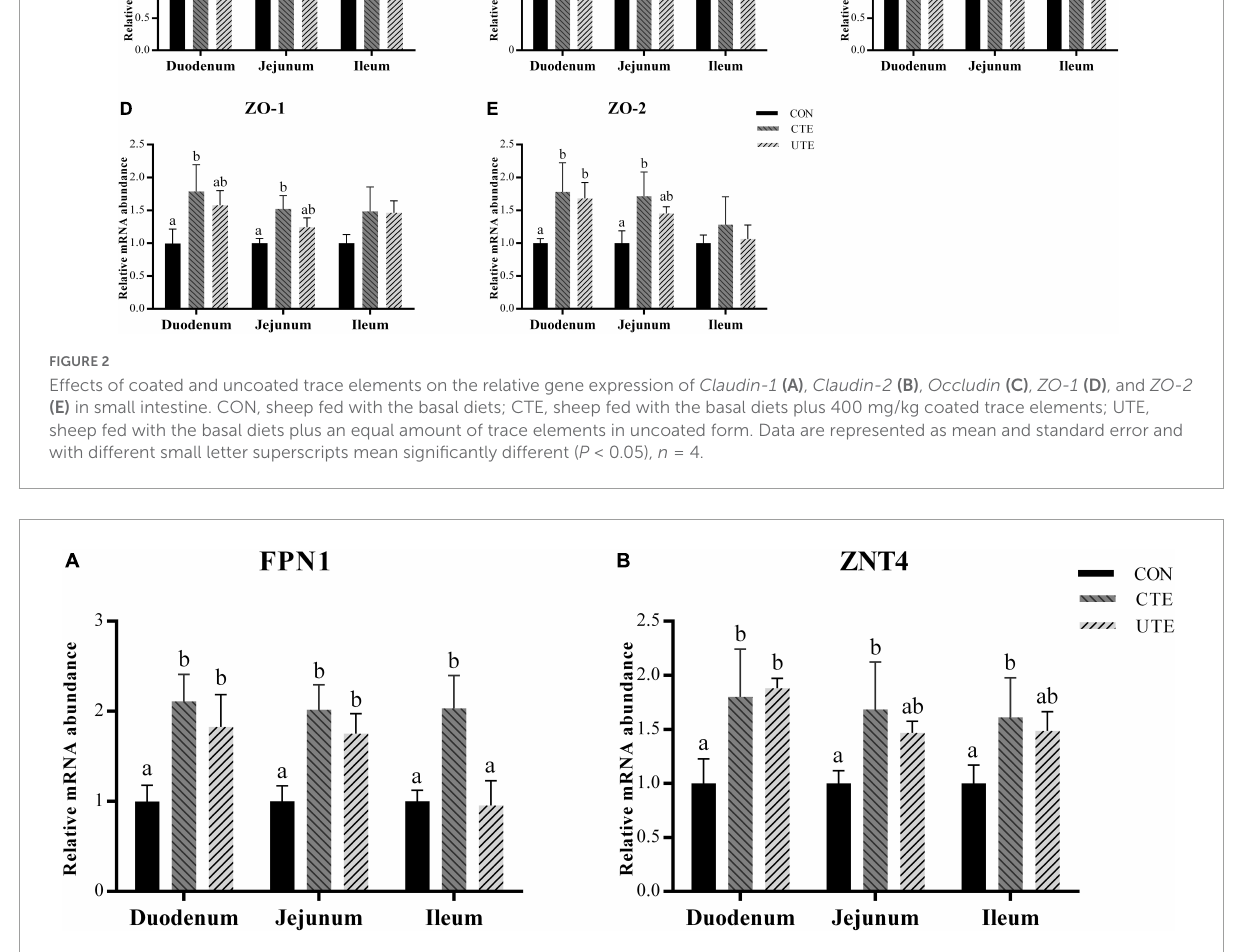
the dominant phyla of colon bacteria were Firmicutes